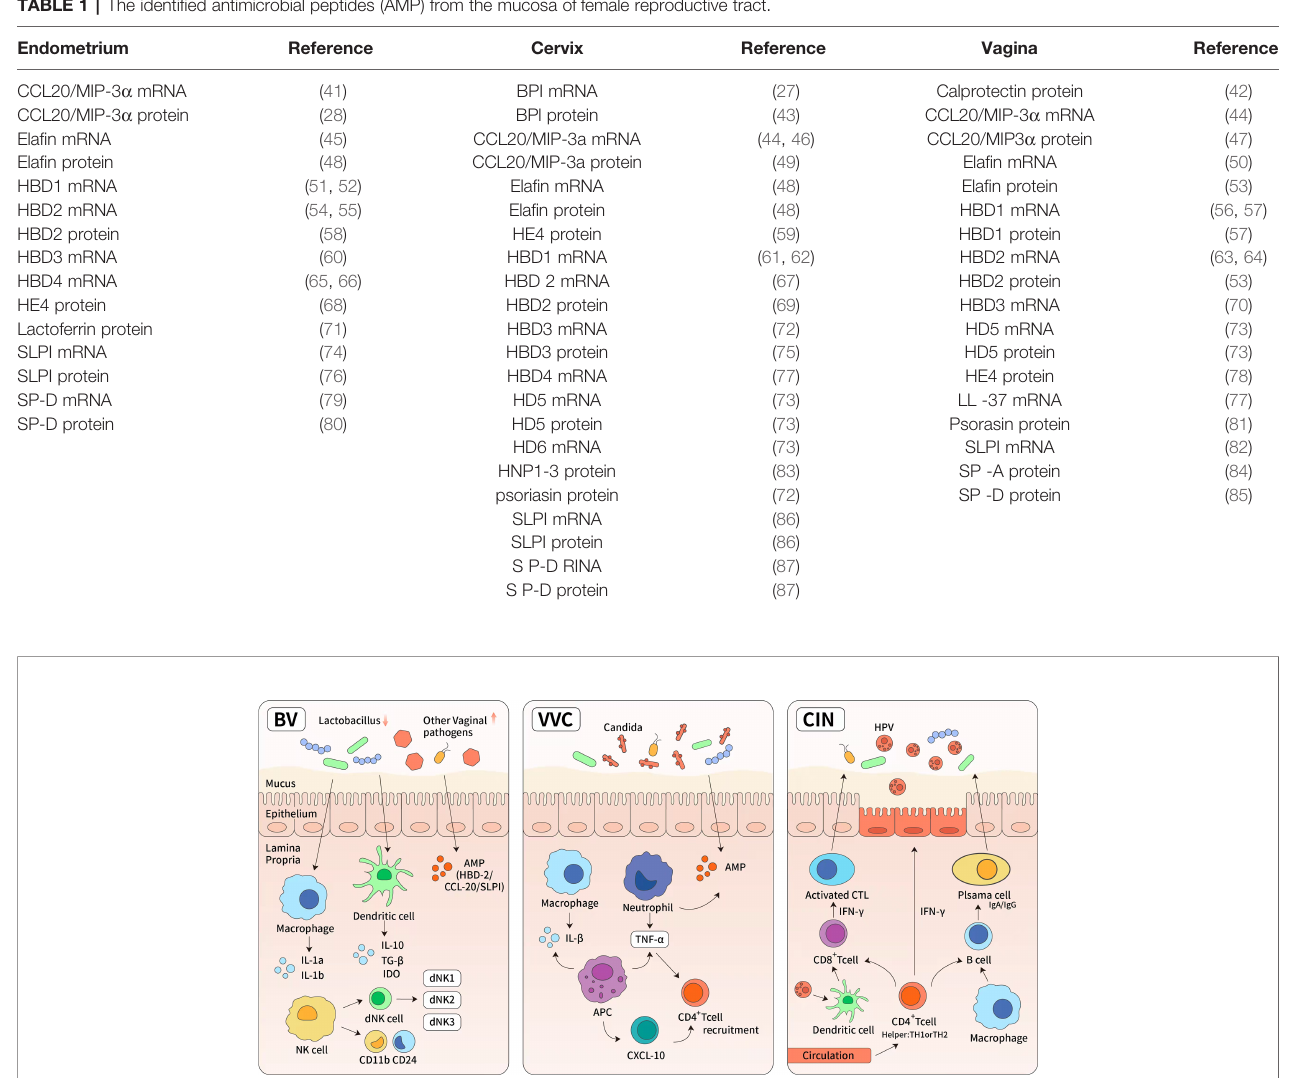
FIGURE 4 | The immune response of reproductive tract diseases. (1) Bacterial vaginosis (BV) is characterized by signi fi cant reduction of normal Lactobacillus-dominated microbiota and the overgrowth of anaerobic organisms. These changes lead to higher vaginal pH and increased cytokines, such as IL-8, IL-1a, IL1b, interferon and tumor necrosis factor. (2) Vulvar vaginal candida is predominantly caused by albicans . It induces the upregulation of light chain 3, lysosome-associated membrane protein 1, and cytokines (tumor necrosis factor- a and IL-1), then leading to the activation of cellular autophagy. The speci fi c bacterial species were found in highly diverse and Lactobacillus-de fi cient cervicovaginal bacteria communities. Antigen presentation cells have also been shown to produce chemokine (C-X-C motif) ligand 10 (CXCL10) which can lead to an increase in the number of activated CD4+ T cells. (3) Antivirus-speci fi c immune responses are essential for the eradication of HPV infection, which requires the cooperation of CD4 + Th cells (TH) and cytotoxic CD8+ T cells. It has also been demonstrated that there are numerous CD4+ Th cells and activated TH-1 and TH-2 cells in persistent high-risk human papillomavirus infection. The high levels of interferon- g secreted by Th-1 cells are known to mediate cytotoxic T cells and directly block viral cytotoxic activity.